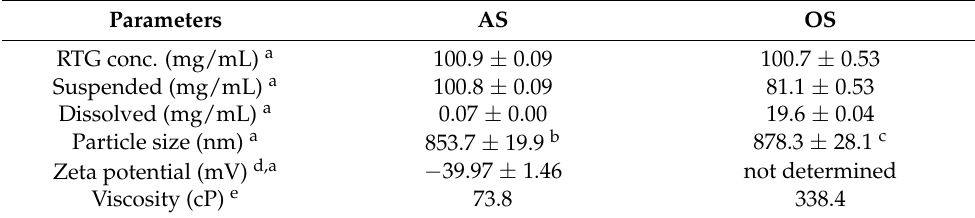
Table 3. Physicochemical characteristics of RTG-loaded AS and OS formulations.